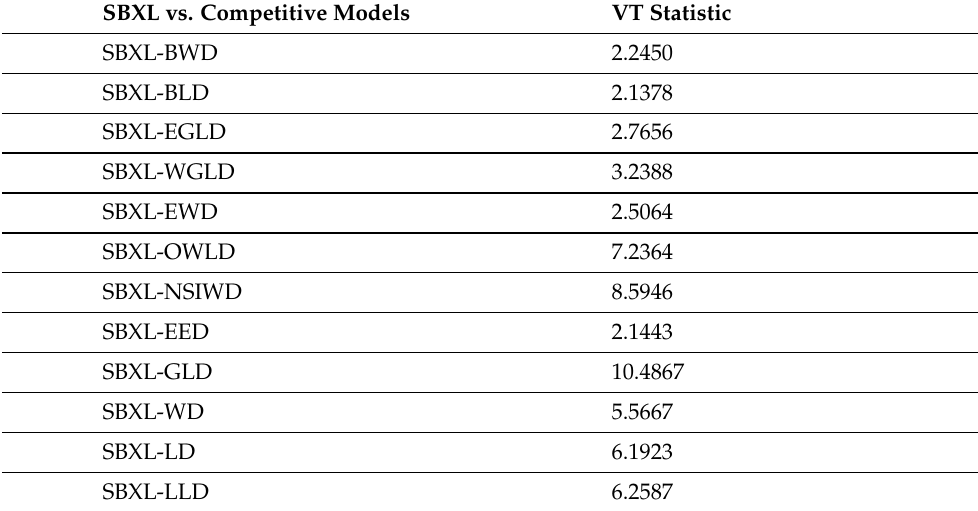
Table 29. Vuong’s test applied for the SBXL model on data set V at Z 0.05 = 1.6495. SBXL vs. Competitive Models